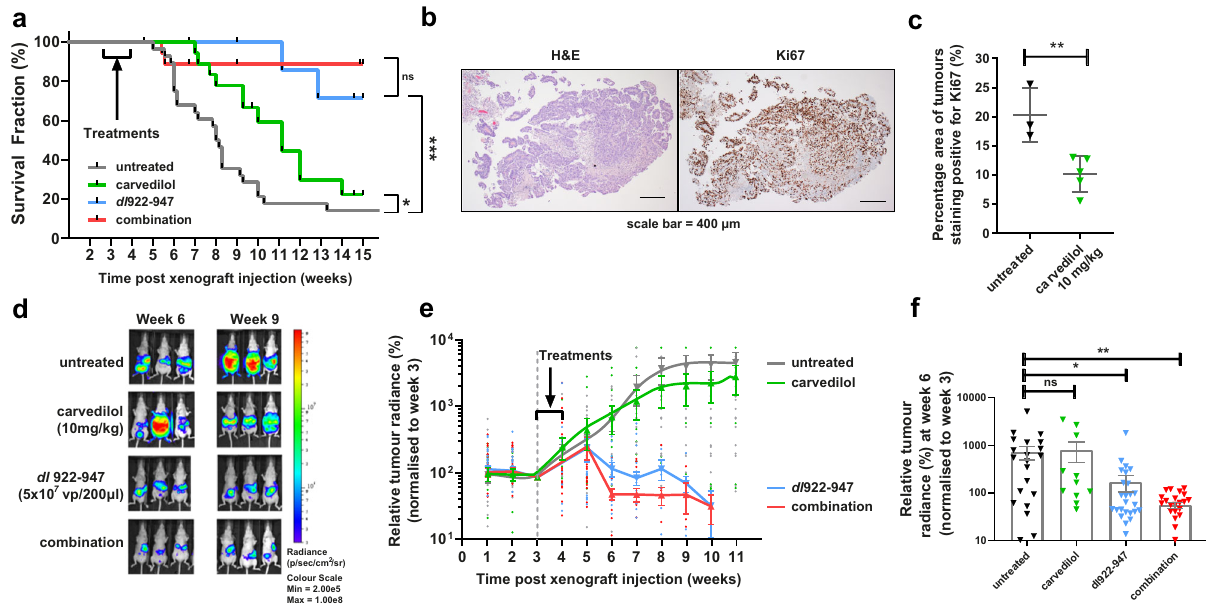
Fig. 5 Carvedilol improves the oncolytic ef fi cacy of dl 922-947 in intraperitoneal murine xenograft models. a Kaplan and Meier survival curves of Ov4Carbo tumour-bearing mice treated with vehicle ( n = 28), carvedilol (10 mg/kg, n = 18), dl 922-947 (5 × 10 7 vp/200 μ l, n = 22) and the combination ( n = 23) (from three biological repeat experiments; Log-rank (mantel-Cox) test; ns P > 0.05; * P ≤ 0.05; *** P ≤ 0.0001). b Representative histology images of tumour samples stained with H&E and Ki67 (scale bar: 400 μ m). c Percentage of total surface area of tumour samples treated with vehicle ( n = 3) and carvedilol (10 mg/kg, n = 5) staining positive for Ki67 (mean ± SD, unpaired t -test, ** P ≤ 0.01) d Representative images of luciferin radiance at weeks 6 and 9. e Tumour-associated luciferin radiance over time normalised to baseline readings (week 3) prior to treatments with vehicle ( n = 28), carvedilol (10 mg/ kg, n = 18), dl 922-947 (5 × 10 7 vp/200 μ l, n = 22) and the combination ( n = 23) (from three biological repeat experiments, mean ± SEM). f Tumour- associated luciferin radiance at week 6 (vehicle n = 24, carvedilol n = 11, dl 922-947 n = 28, combination n = 25 mice from three repeat